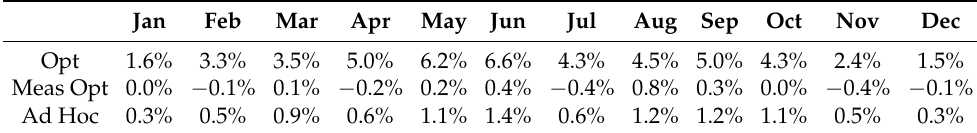
Table 12. Monthly PV self-consumption improvement for the building cluster.